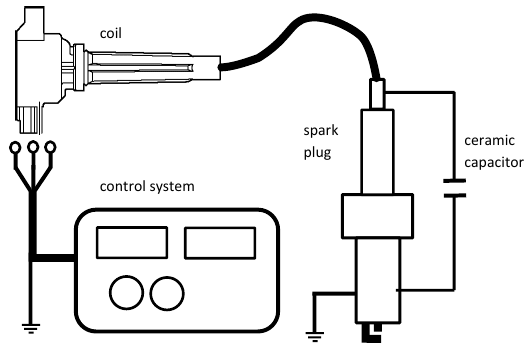
Fig. 2. Setup diagram of a high power ignition